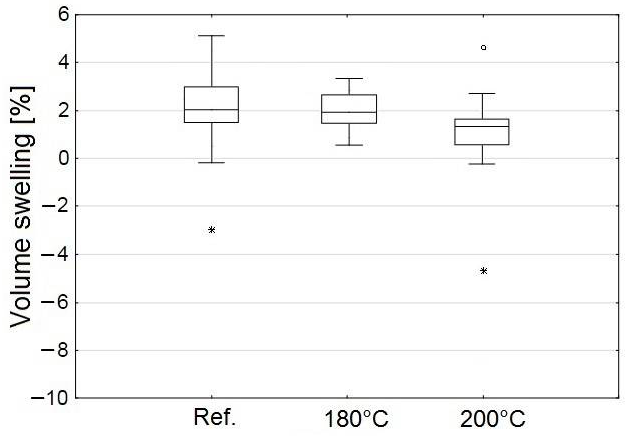
Figure 5. Volume swelling in the following three groups of specimens: Ref. (unmodified), modified at 180 ◦ C, and modified at 200 ◦ C, ◦ —outlier values; *—extreme